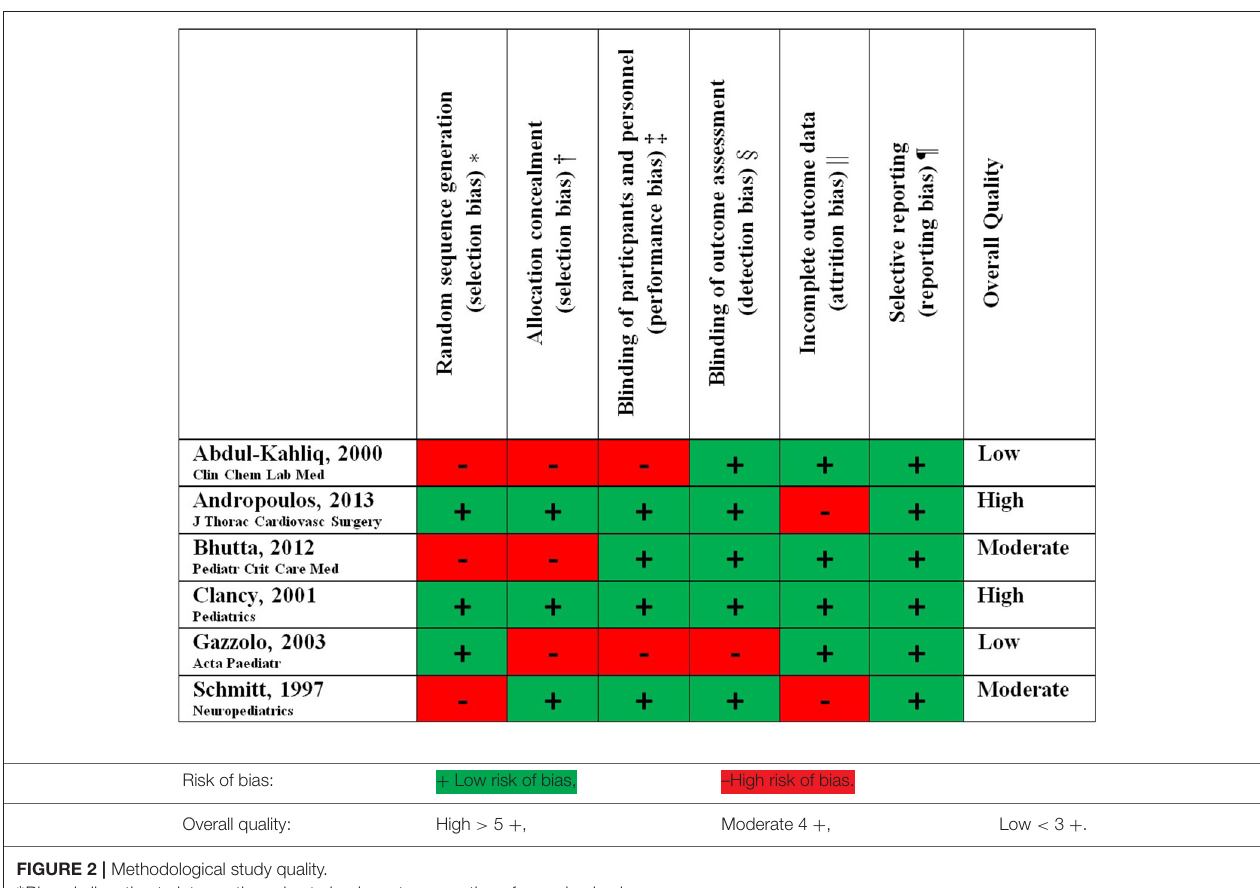
FIGURE 2 | Methodological study quality. ∗ Biased allocation to interventions due to inadequate generation of a randomized sequence. † Biased allocation to interventions due to inadequate concealment of allocations prior to assignment. ‡ Knowledge of the allocated interventions by participants and personnel during the study. § Knowledge of the allocated interventions by outcome assessors. || Amount, nature or handling of incomplete outcome data. ¶Selective outcome